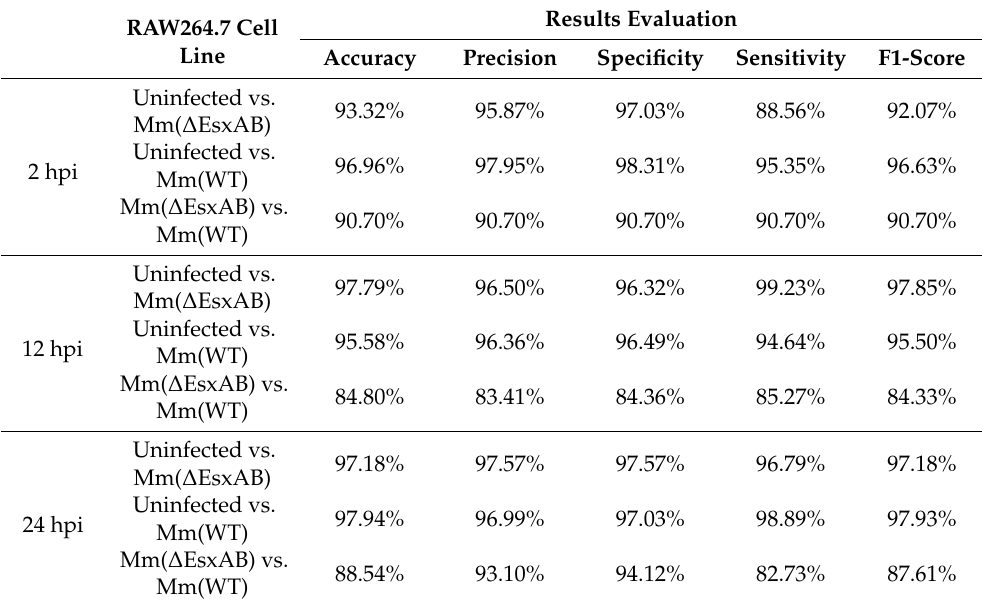
Table 4. The performance of the proposed AutoCellANLS on RAW264.7 cell dataset. RAW264.7